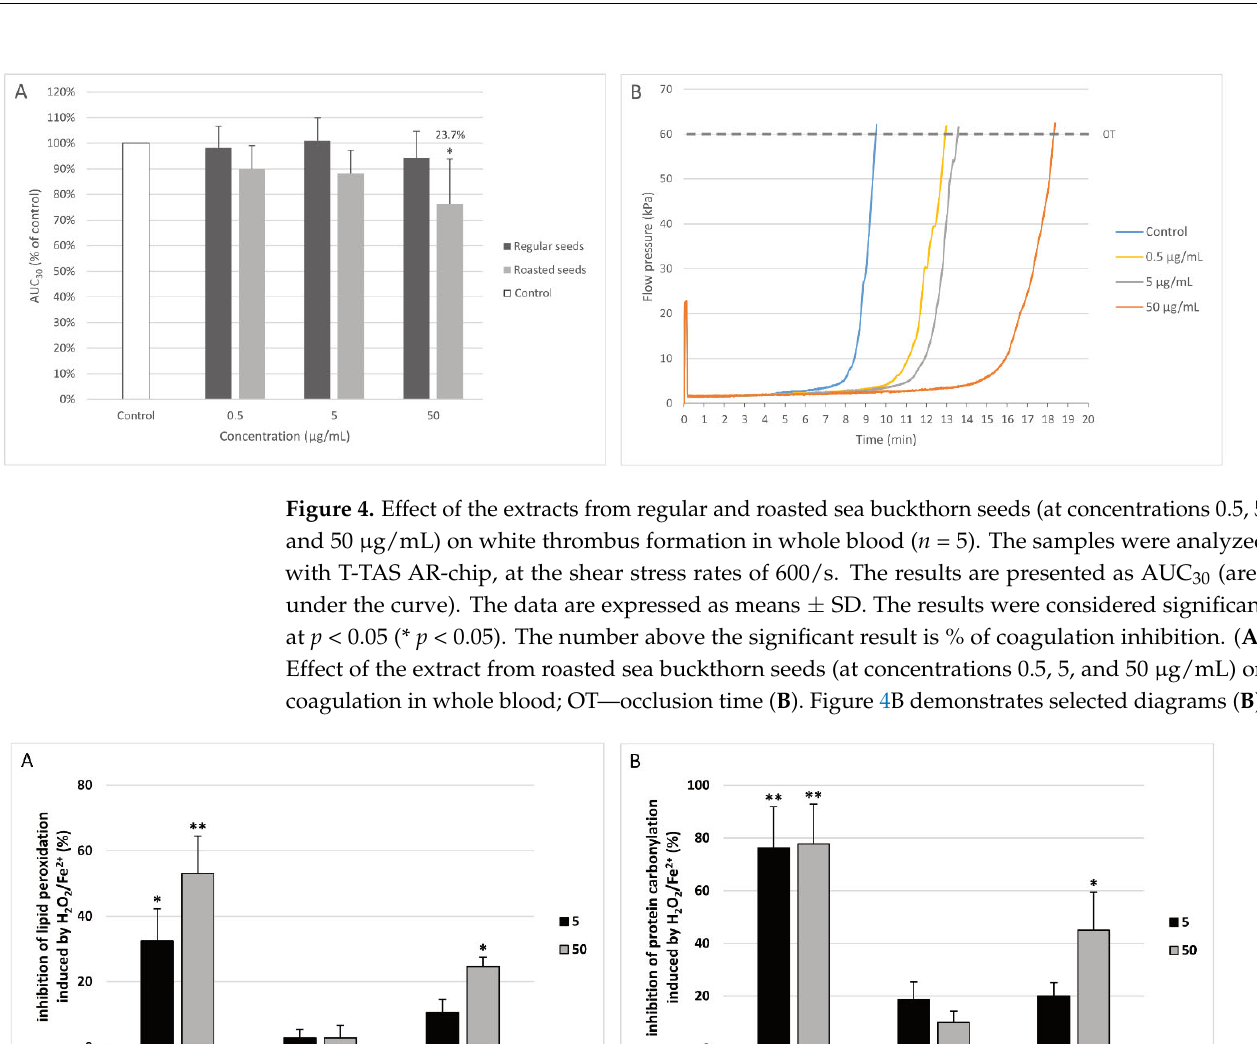
Figure 5. Comparative antioxidant activity of the extract from regular sea buckthorn seeds (at con- centrations: 5 and 50 µ g/mL, pre-incubation time—5 min), phenolic preparation from sea buckthorn fruits (at concentrations: 5 and 50 µ g/mL, pre-incubation time—5 min) and non-polar preparation from sea buckthorn fruits (at concentrations: 5 and 50 µ g/mL, pre-incubation time—5 min) in plasma treated with H 2 O 2 /Fe 2+ (incubation time—25 min). Results are given as mean ± SD ( n = 8). Kruskal- Wallis test: ( A ) for lipid peroxidation: * p < 0.05 (preparation of sea buckthorn seeds (at concentration: 1 µ g/mL) vs. phenolic preparation of sea buckthorn fruits (at concentrations: 1 µ g/mL) non-polar preparation of sea buckthorn fruits (at concentrations: 5 µ g/mL); ** p < 0.01 (preparation of sea buckthorn seeds (at concentration: 50 µ g/mL) vs. phenolic preparation of sea buckthorn fruits (at concentrations: 50 µ g/mL)/non-polar preparation of sea buckthorn fruits (at concentrations: 50 µ g/mL); ( B ) for protein carbonylation: * p < 0.05, ** p < 0.01 (preparation of sea buckthorn seeds (at concentration: 5 and 50 µ g/mL) vs. phenolic preparation of sea buckthorn fruits (at concentrations: 5 and 50 µ g/mL) non-polar preparation of sea buckthorn fruits (at concentrations: 5 and 50 µ